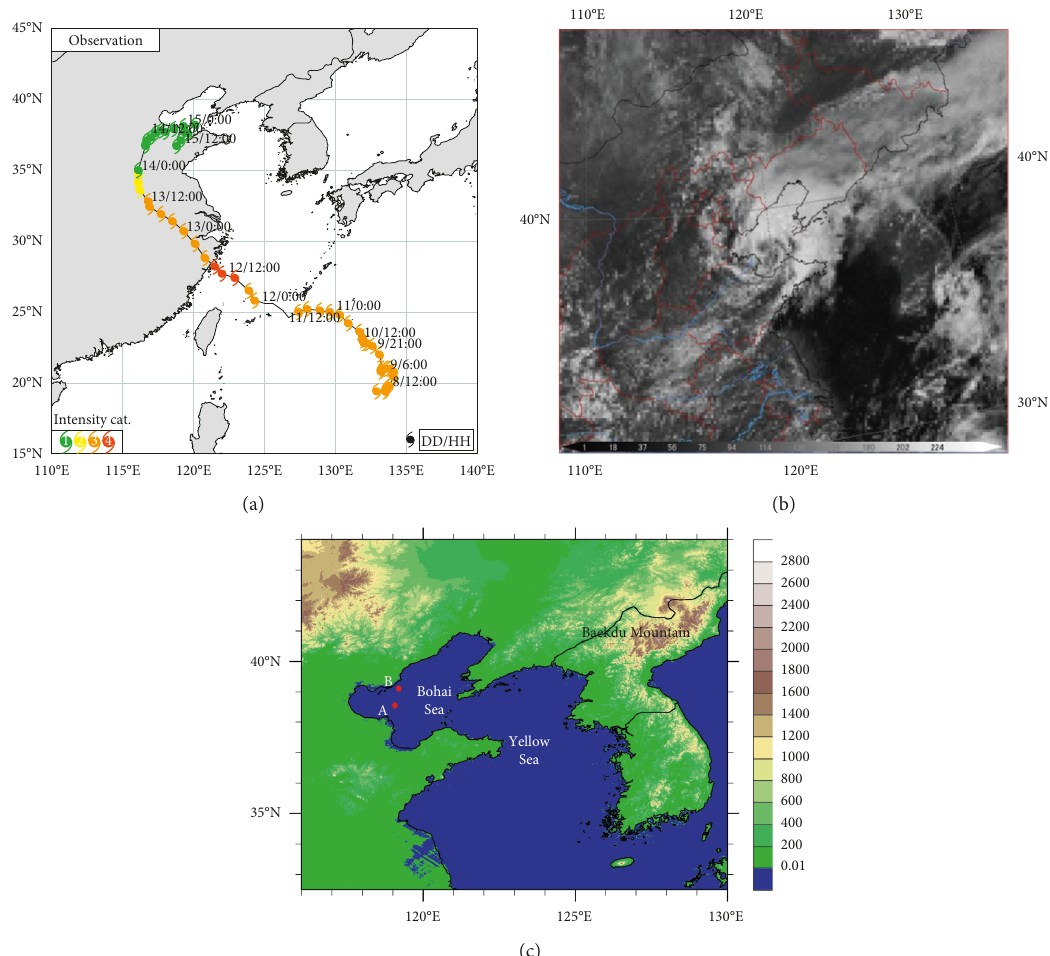
Figure 2: (a) Track of TC Yagi. The different-colored points represent different intensities. Green points represent Yagi after it lost its numerical designation; yellow points represent tropical depression strength; orange points represent tropical storm strength; red-orange points represent severe tropical storm strength. (b) Visible cloud image of Yagi from the FY2 satellite at 0400 UTC 15 August. (c) Terrain around the Bohai Sea. Points A and B represent the location of the 2 automated observation